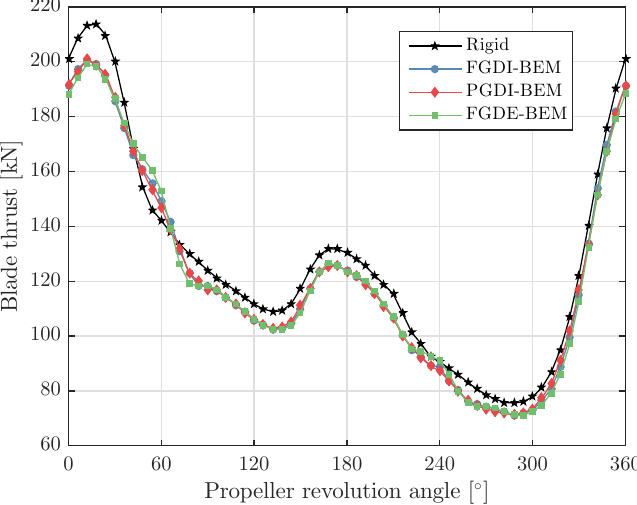
Figure 13. Blade thrust computed with different BEM-FEM couplings for the carbon–epoxy Seiun– Maru